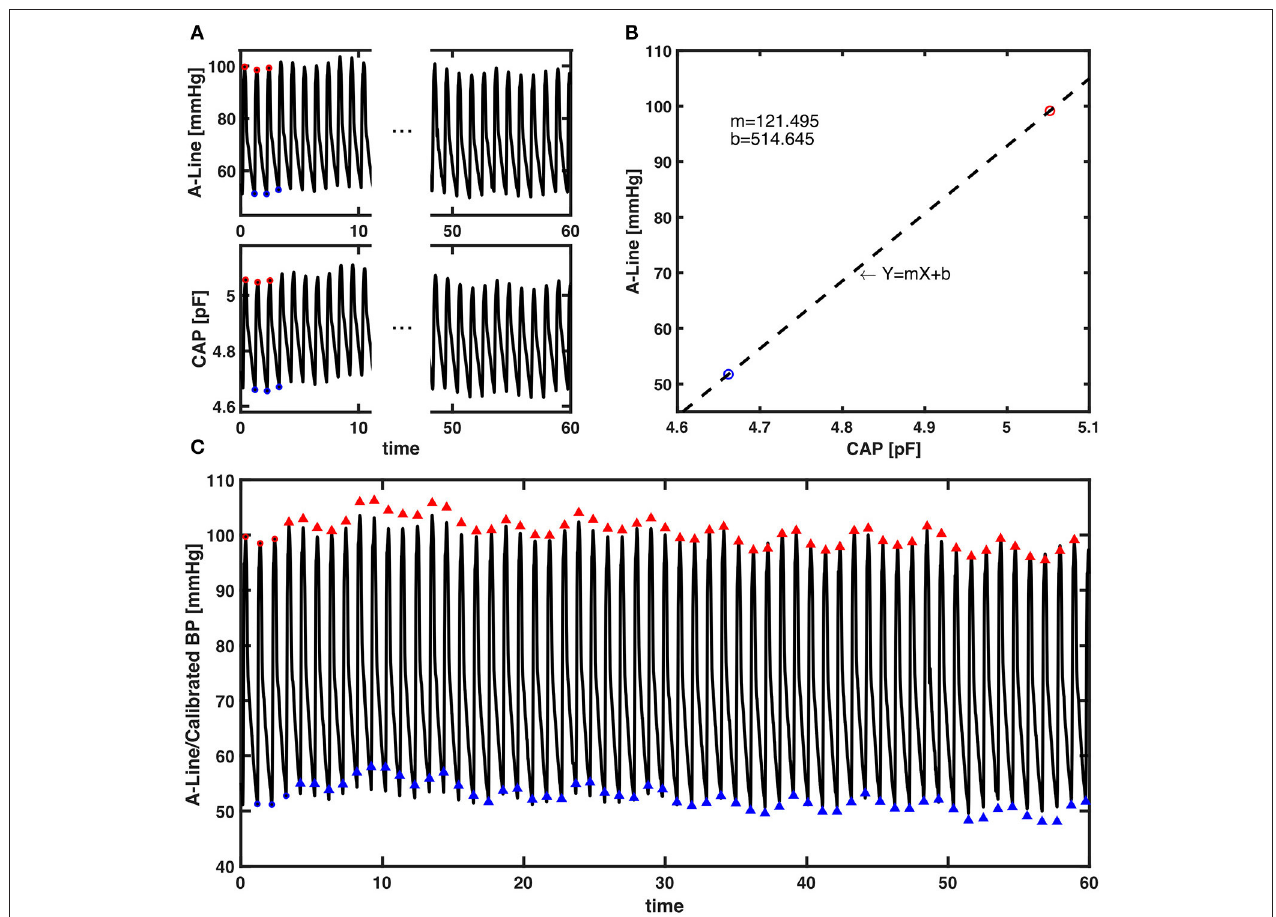
FIGURE 4 | The presented calibration algorithm. (A) An example of a 60-s epoch raw signal acquired from A-Line and the CAP sensor. The red and blue circles are first three systolic and diastolic pressure values extracted for calibration from each signal, respectively. (B) Linear regression that models the relationship between the averaged systolic (red) and diastolic (blue) pressure values of A-Line and the CAP sensor from the first three beats. The dashed line is a linear regression line that forms the equation with m the slope and b the intercept. (C) The raw 60-s signal of A-Line, first three beats of SBP and DBP (red/blue circles), and the SBP and DBP values (red/blue triangles) calibrated from the CAP signal using the presented calibration